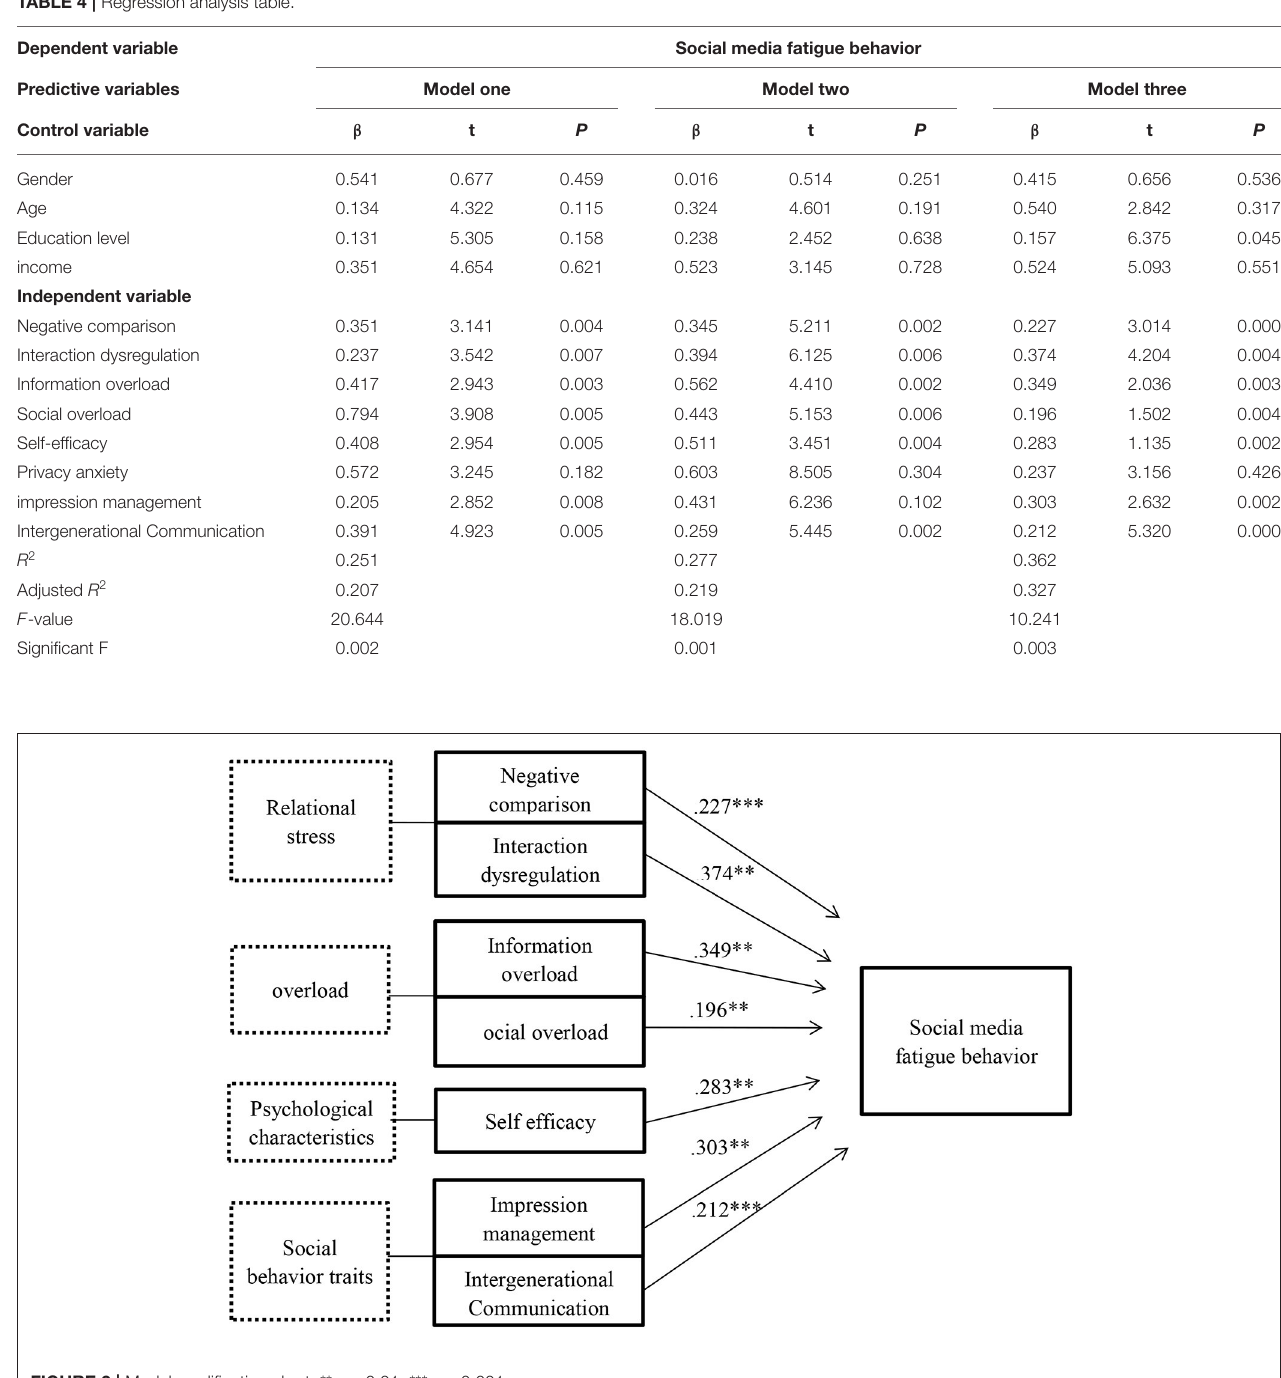
FIGURE 2 | Model modification chart. ** p < 0.01, *** p <